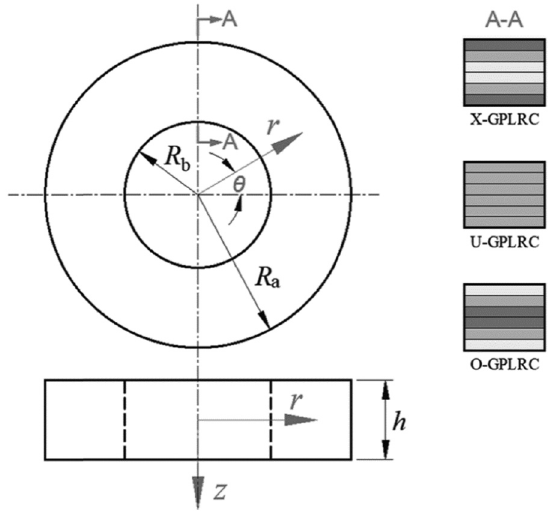
Figure 2: Geometry of FG - GPLRC multilayer annular plates [ 19 ]